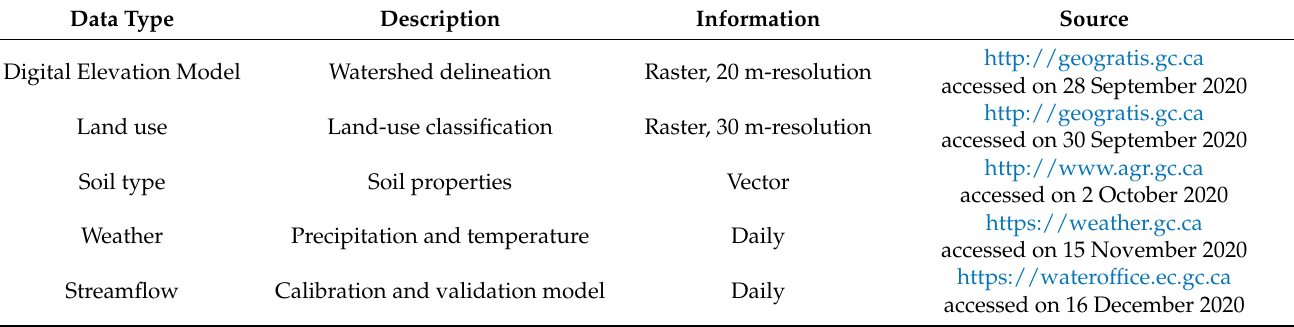
Figure 1. Flow chart of the modeling program. Table 1. Input data used in SWAT model.